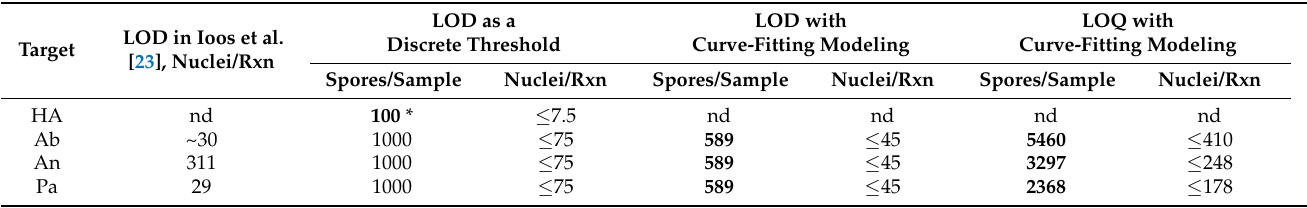
Table 2. Limits of detection (LOD) and quantification (LOQ) in qPCR assays. HA, Heterobasidion annosum s.l.; Ab, Heterobasidion abietinum ; An, Heterobasidion annosum s.s.; Pa, Heterobasidion parviporum ; nd, not determined. Bold values were used for the interpretation of qPCR